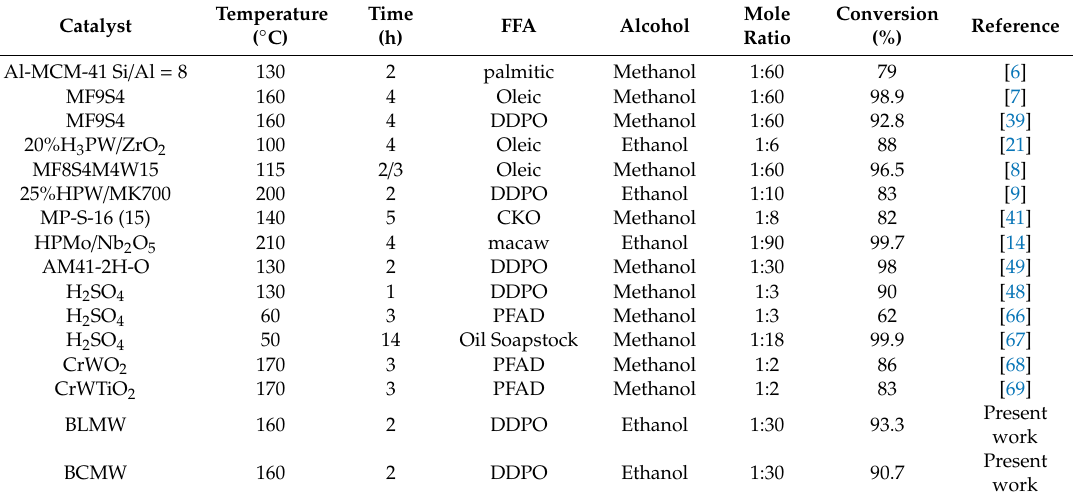
Table 4. Results of free fatty acid esterification (FFA) catalyzed by different solid acid catalysts.